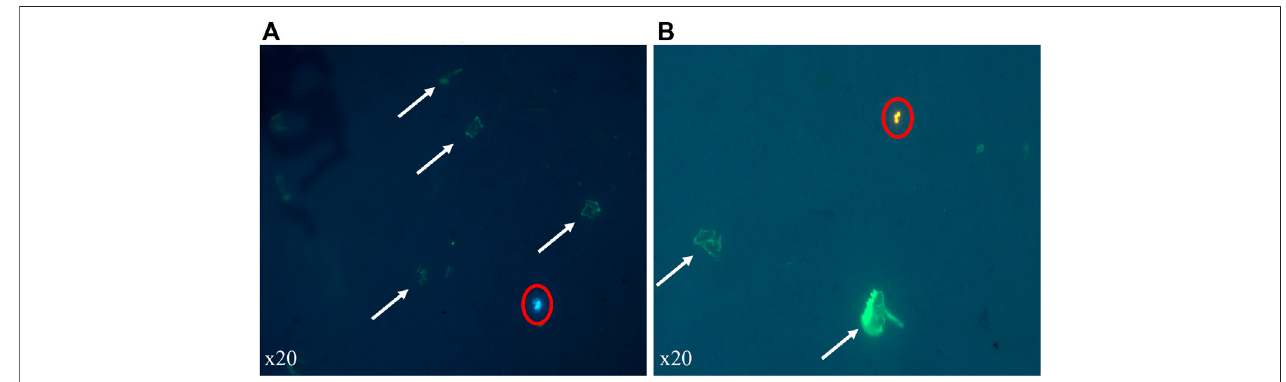
FIGURE 3 | Observation of experimental copepods contaminated with MPs (red circles) of LDPE (A) and PS (B) and digested on black polycarbonate membrane fi lters. Filters were stained with Nile Red and observed with epi fl uorescence microscopy (crime light: 455 – 494 nm). Residual ’ s cuticle fragments are present as green translucent particles (white arrows).